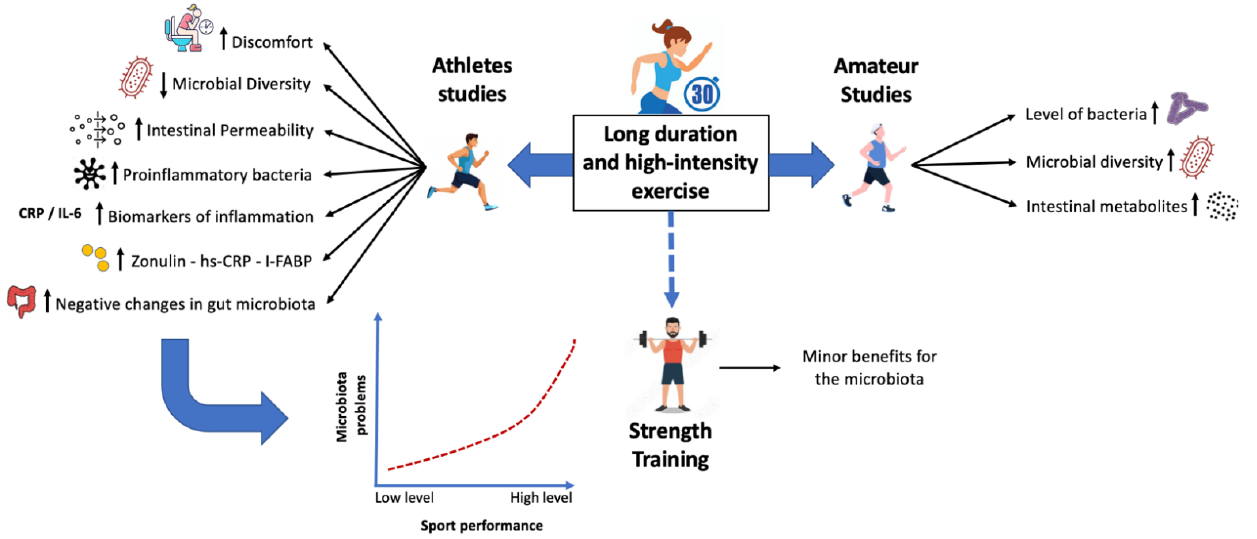
Figure 2. Interaction of different intensities and duration of exercise on the intestinal microbiota. Abbreviations: CRP, C-reactive protein; hs-CRP, high-sensitivity C-reactive protein; I-FABP, intestinal fatty-acid binding protein; IL, interleukin.